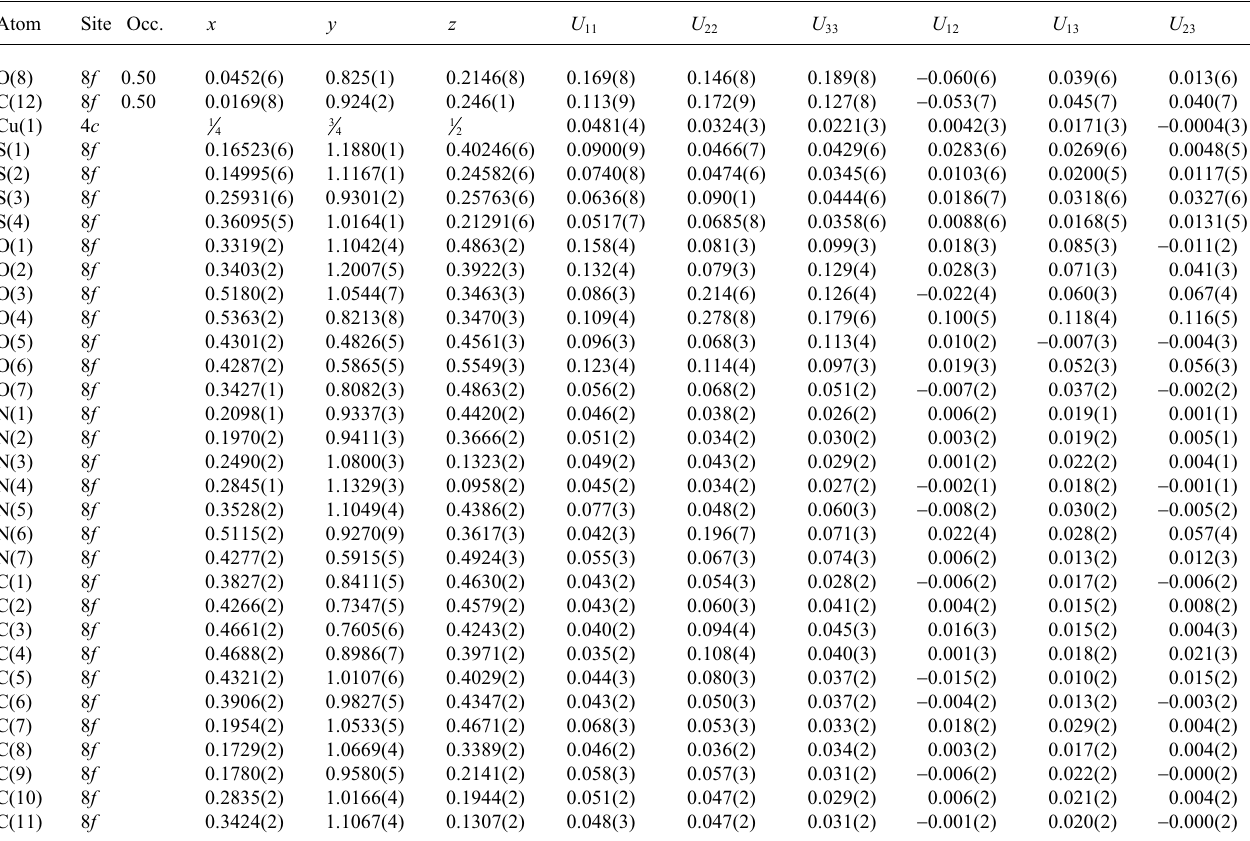
Table 3. Atomic coordinates and displacement parameters (in Å 2 ). Atom Site